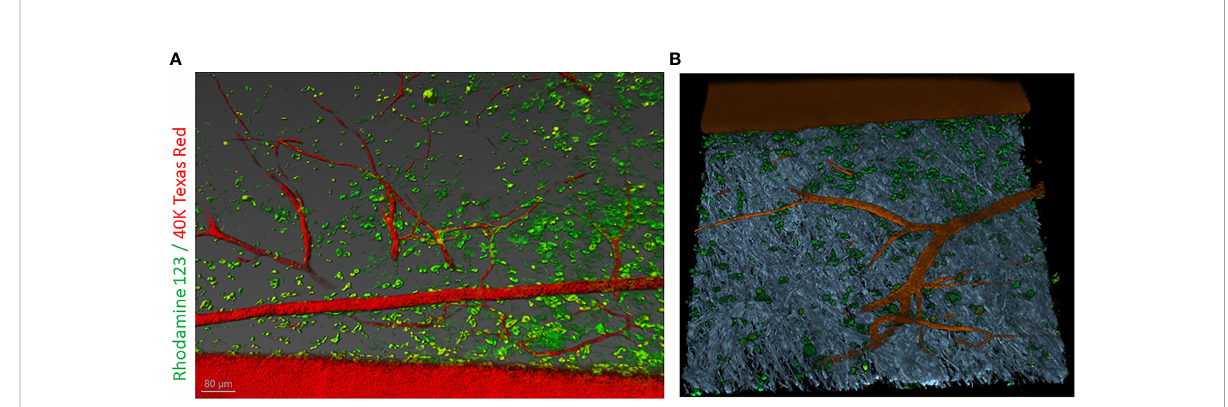
FIGURE 6 Intravital labeling for two-photon microscopic imaging of adult mouse skin vasculature. (A) Texas Red 40 KDa dextran marked the perfused vasculature and Rhodamine-123 marked the cytoplasm of cells present nearby the vasculature containing mitochondria. Scale bar = 80 µm. (B) Using Imaris software the 3-dimensional vessel structure was reconstructed from a region of interest (ROI) from panel (A) Grey color represent second-harmonic generation (SHG) indicative of collagen in the skin